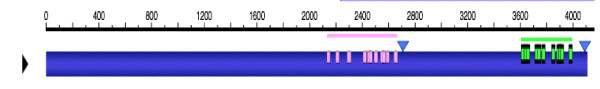
Screen shot of the Affymetrix probe set display tool showing the consensus sequence for probe sets 1368596_at and 1368597_at (blue bar) [29]. The arrow at the left shows the 5' to 3' direction along the consensus sequence. The pink bars represent the 1368597_at probes, and the green bars the 1368596_at probes. The blue triangles above the consensus sequence show poly(A) sites.